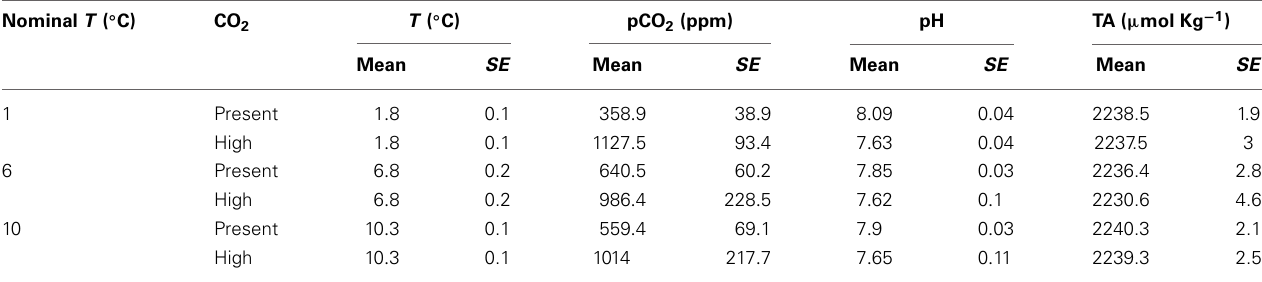
Table 1 | Mean or median ± SE of the recorded experimental conditions (temperature, p CO 2 , pH, and total alkalinity) for the nominal experimental